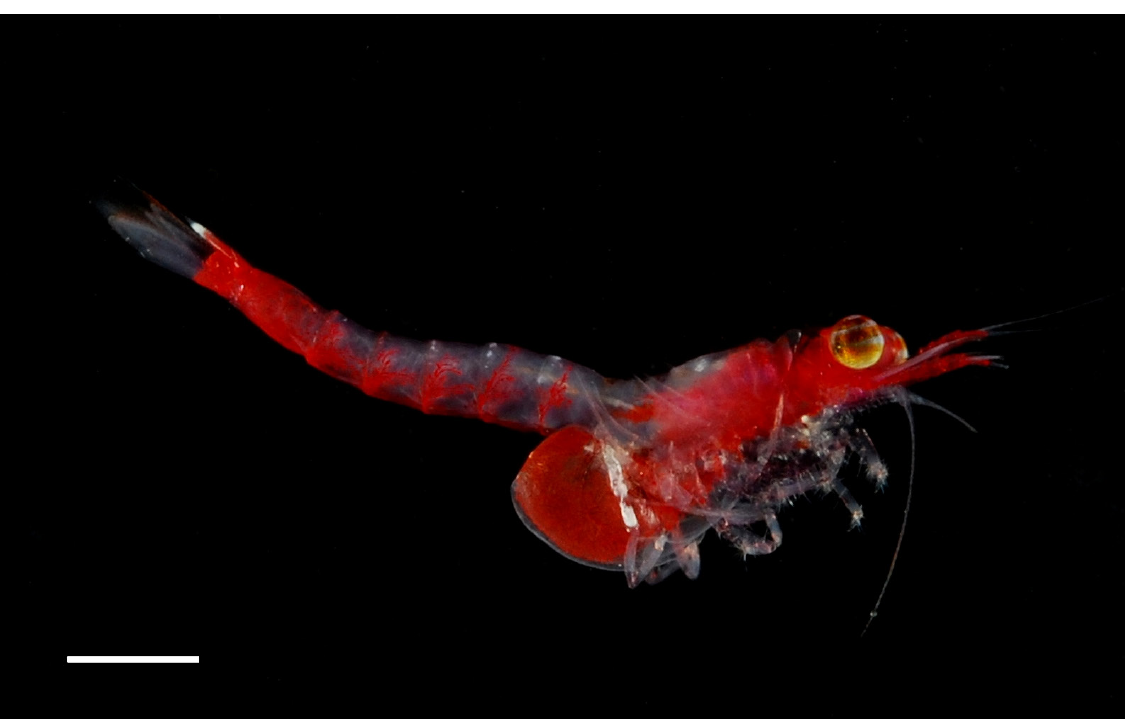
Fig. 22. Siriella tabaniocula sp. nov., holotype, ♀, length 6 mm, Ningaloo Reef, Western Australia. Color photograph of living specimen. Scale bar: 1